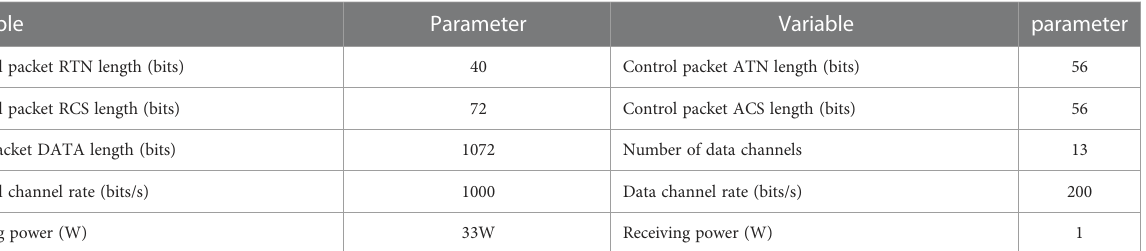
TABLE 3 Network simulation parameters.